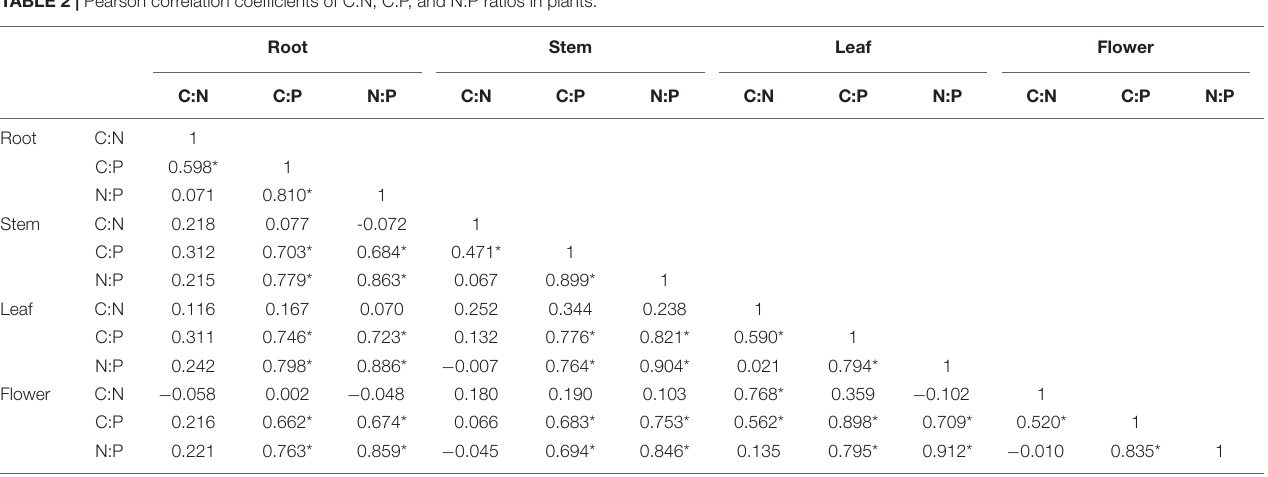
FIGURE 2 | Distribution of C:N, C:P, and N:P molar ratios in soils and plants. The sample size is 43 for soil and 45 for each plant organ. TABLE 2 | Pearson correlation coefficients of C:N, C:P, and N:P ratios in